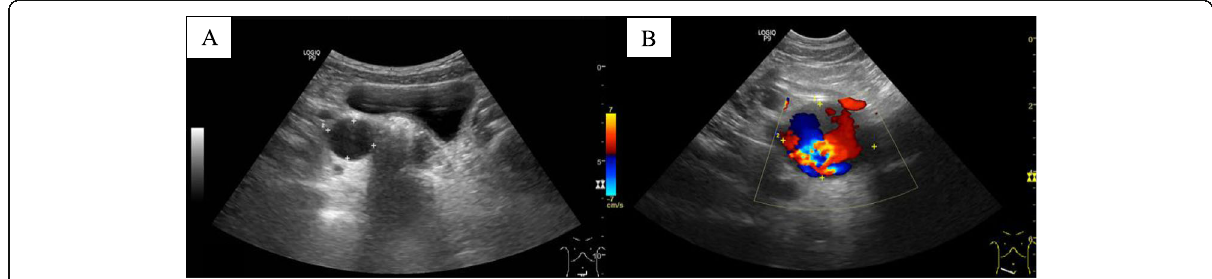
Fig. 3 Ultrasound of the pelvis shows cystic lesion in right hemipelvis ( a ). Turbulent flow on color Doppler within the cystic lesion ( b